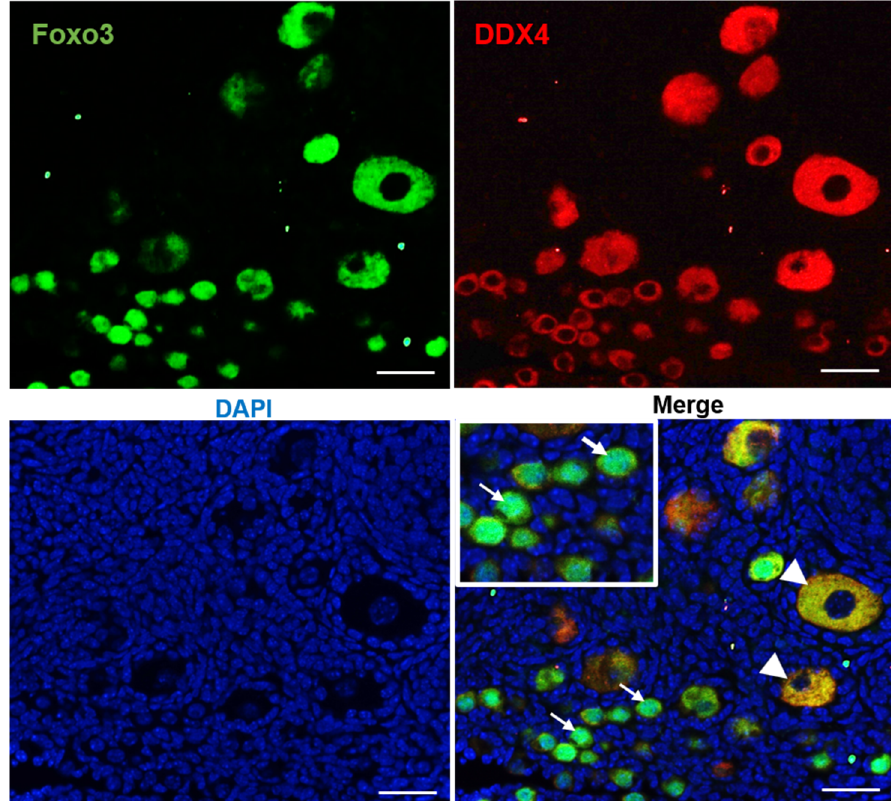
Figure 2. The expression of Foxo3 in primordial follicles and growing follicles. Foxo3 (green) is expressed in the nucleus of primordial follicles. In growing follicles, Foxo3 is translocated to the cytoplasm. DDX4 (red) was used as the germ cell marker, and DAPI (blue) was used to stain DNA. Arrowheads: oocyte cytoplasm with Foxo3. Arrows: oocyte nuclei with Foxo3. Scale bars: 50 µm.